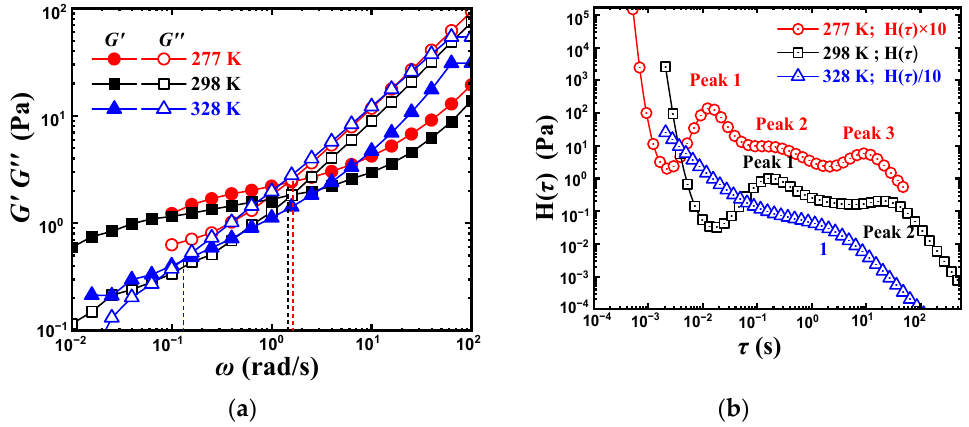
Figure 6. Dynamic rheological behavior and the corresponding relaxation spectrum of 10 wt% PVA at different temperature. ( a ) Dynamic rheological behavior. ( b ) Relaxation spectrum.